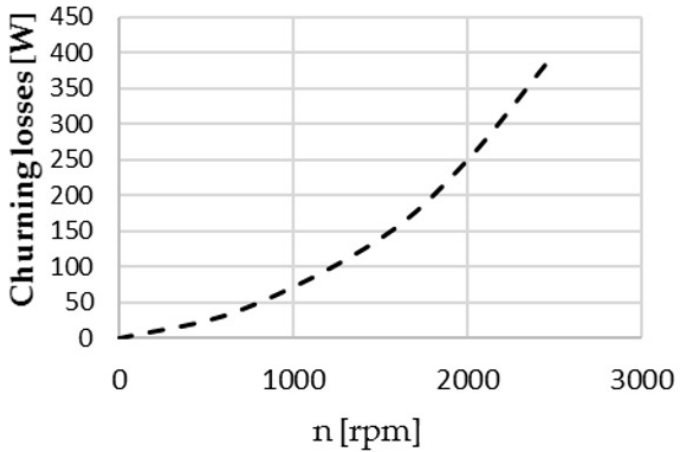
Figure 17. Churning losses of a 52 cc S-APP.